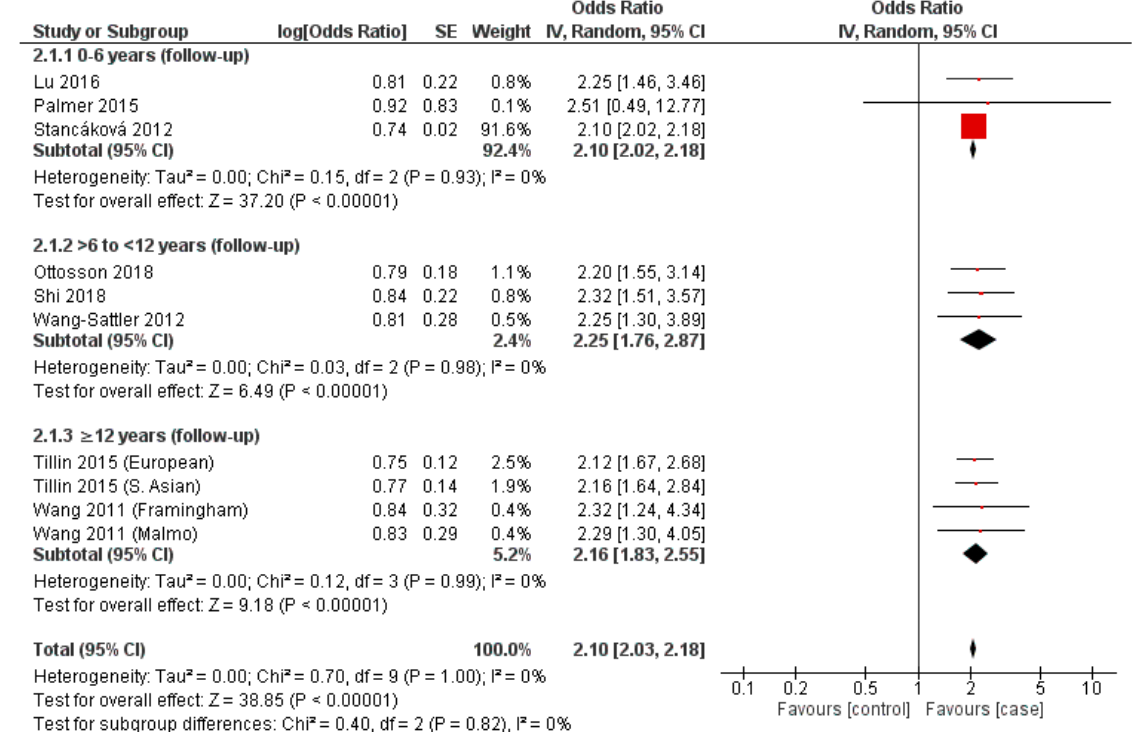
Figure 2. Forest plot depicting the effect sizes of the individual studies for leucine in each of the designated temporal subgroups [29–31,41–46]. designated temporal subgroups [29–31,41–46].